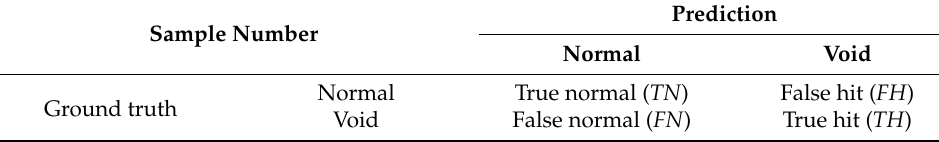
Table 5. The confusion